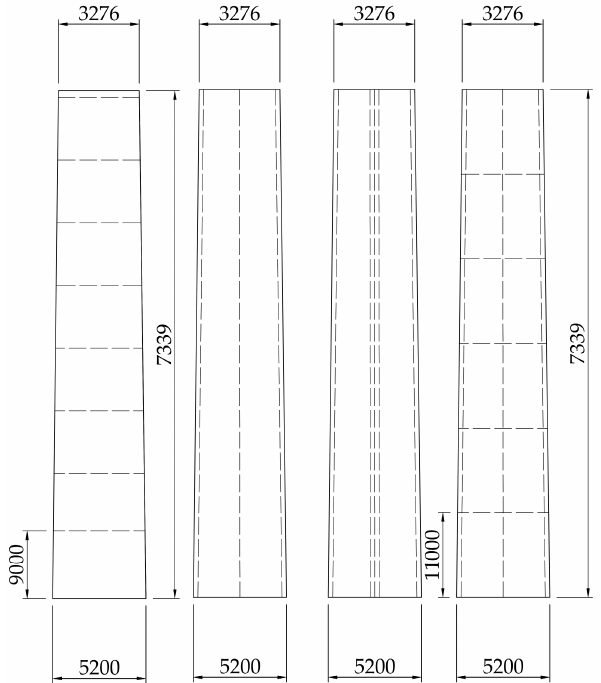
Figure 10. Geometric data of the towers with the four stiffening schemes (in mm).